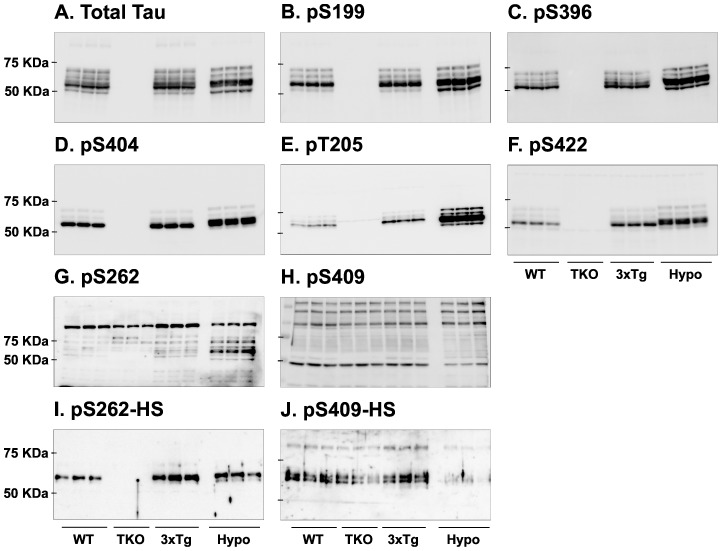
Analysis of tau signal with polyclonal antibodies by Western blotting.Proteins were extracted from the cortex of 3 mouse lines: control mice (WT and Hypothermic), Tau KO mice and 3xTg-AD mice. Proteins were separated by SDS-PAGE and then identified with the following polyclonal antibodies: A: Total Tau, B: pS199, C: pS396, D: pS404, E: pT205, F: pS422, G: pS262 and H: pS409. Normal anti-rabbit secondary antibodies were used to detect primary antibodies. The heat stable fraction was used to remove non-specificity: I: pS262 and J: pS409. Quantifications of the blots are available in Figure S5.